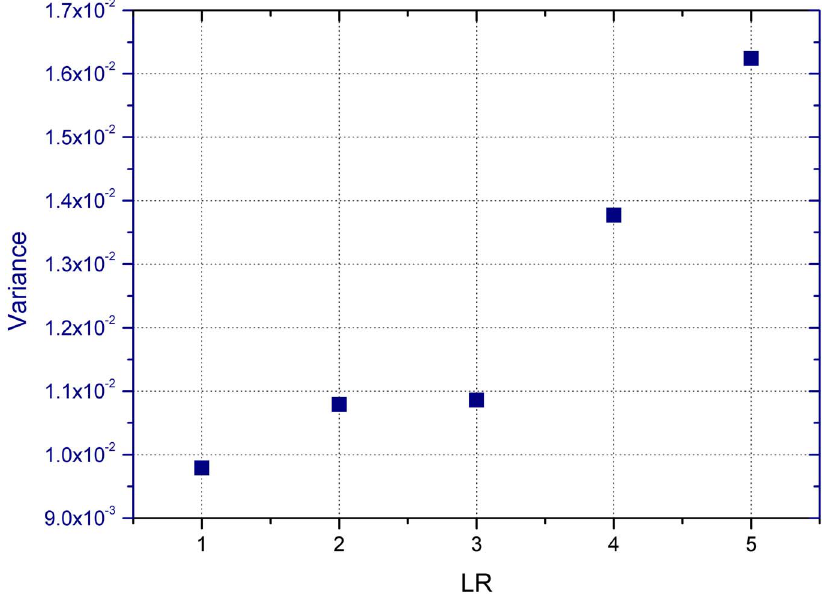
Figure 3. The variance trend of the price return in the experiments. It goes up with the ascending LR , showing that a higher level of leverage brings a higher level of volatility, which is considered as the risk in the market.